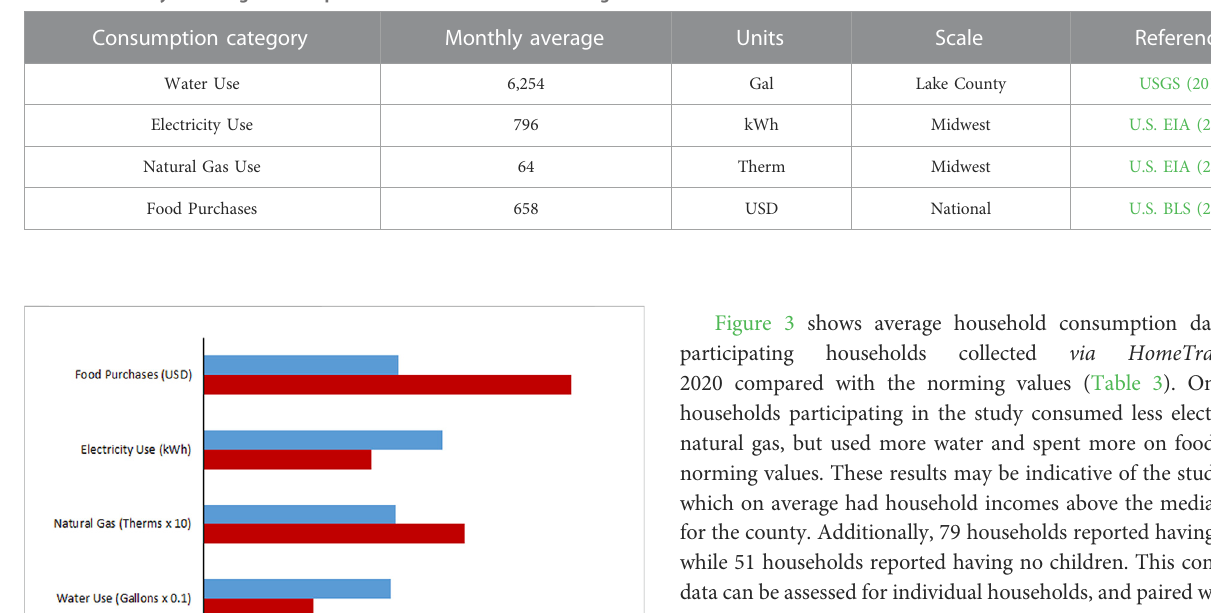
TABLE 3 Summary of average consumption values for household norming feedback.